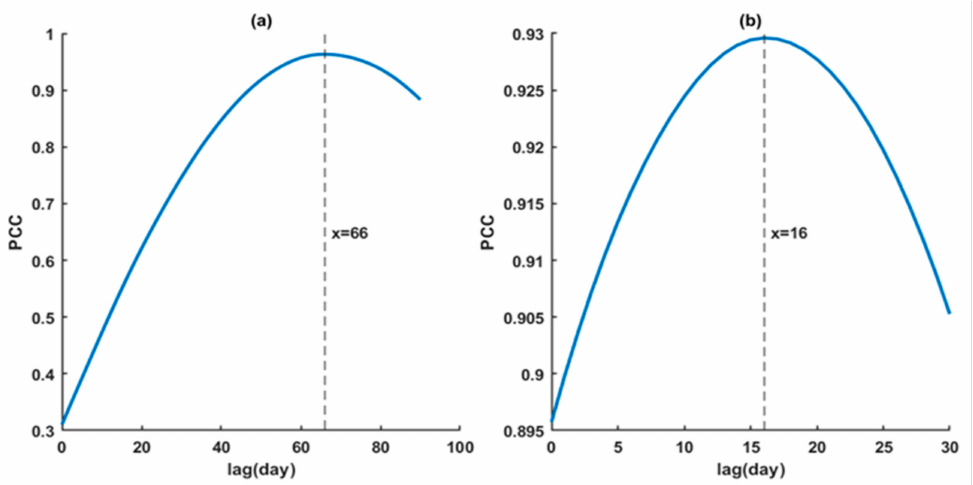
Figure 5. Pearson Correlation coefficient between the in situ runoff and ( a ) TRMM precipitation or ( b ) GRACE land water storage in Yunnan Province up to 90-day (or 30-day) lagged